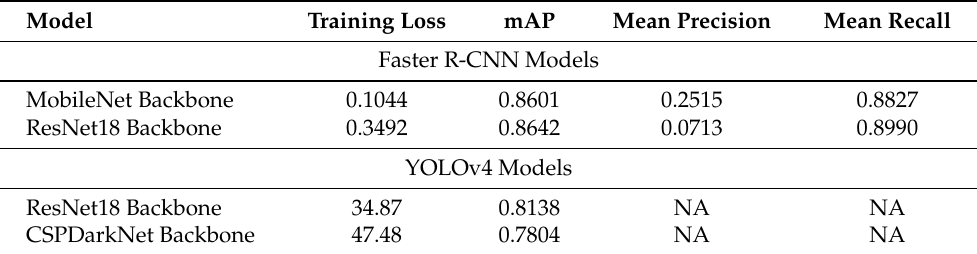
Figure 5. Training mAP Curves for the Different Variants of Computer Vision Object Detection Models Implemented for Floodborne Objects Type Recognition: ( a ) Faster R-CNN Models, ( b ) YOLOv4 Models. Table 2. Quantitative Training Results for the Different Variants of Computer Vision Object Detection Models Implemented for Floodborne Objects Type